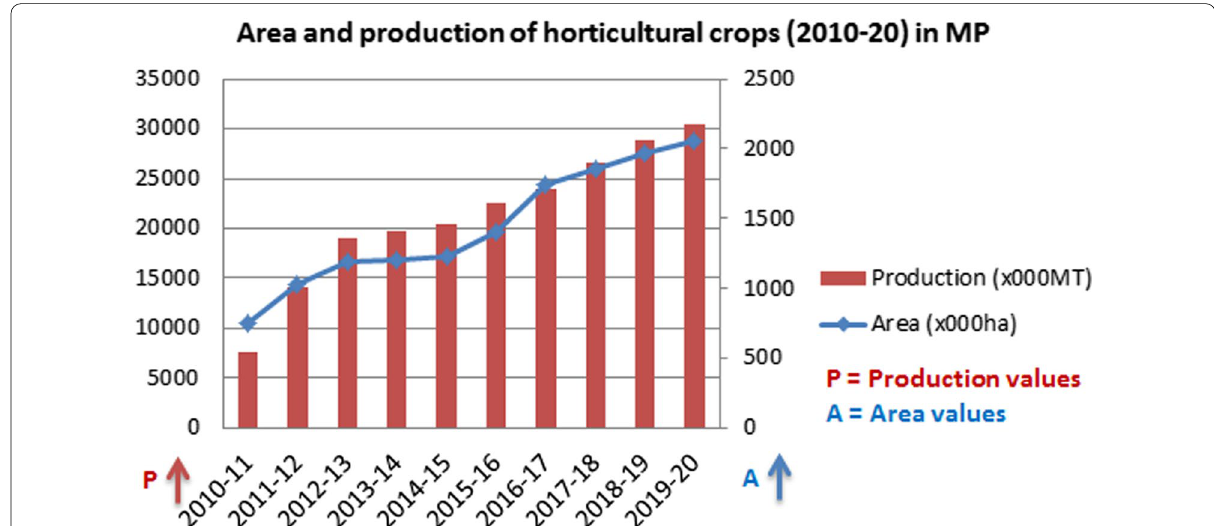
Fig. 11 Decadal growth in area and production of horticultural crops in Madhya Pradesh during 2010–2020. The blue line depicts the area cultivated, whereas the bars show the combined production of horticultural crops of the year. The figure shows that area and production